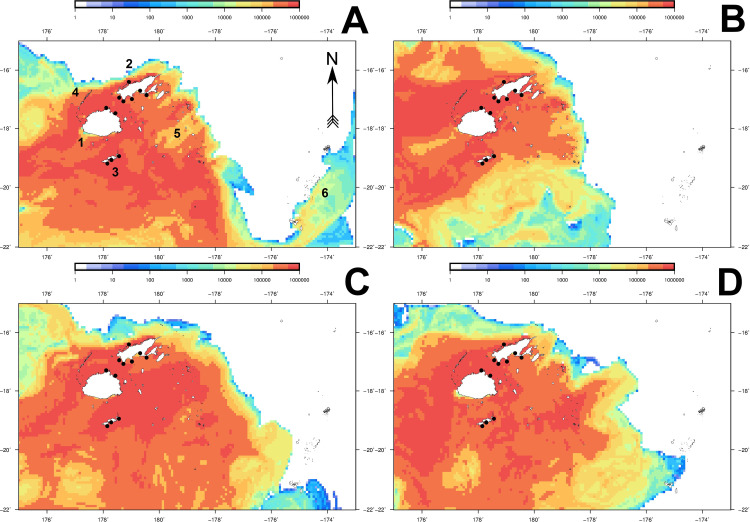
Cumulative particle count heat maps for 2012 and 2013 datasets (non-ENSO years).Final (day 60) particle counts are shown for spawning seasons 1 (A) and 2 (B) for 2012, and seasons 1 (C) and 2 (D) for 2013. Black circles denote the positions of spat collector deployments described by Kishore et al. [22]. The colour legend indicates the cumulative particle visit count within individual 10Km2 grid cells. Numbers denote the following localities: Viti Levu (1), Vanua Levu (2), Kadavu (3), Yasawa archipelago (4), Lau archipelago (5) and the Kingdom of Tonga (6).